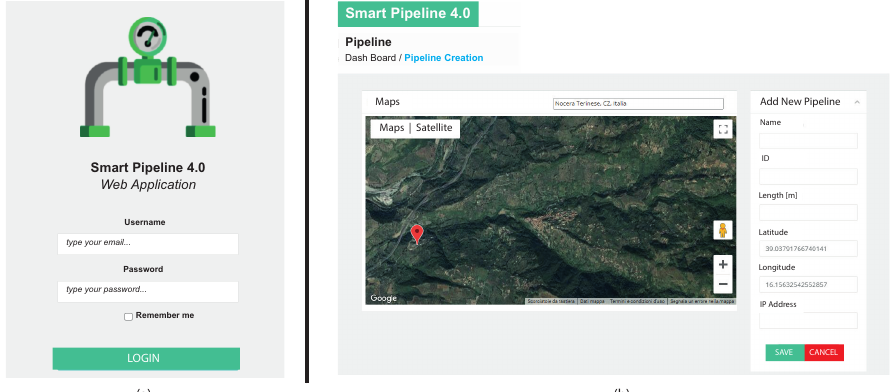
Figure 16. Web application—login page ( a ) and pipeline system configuration ( b